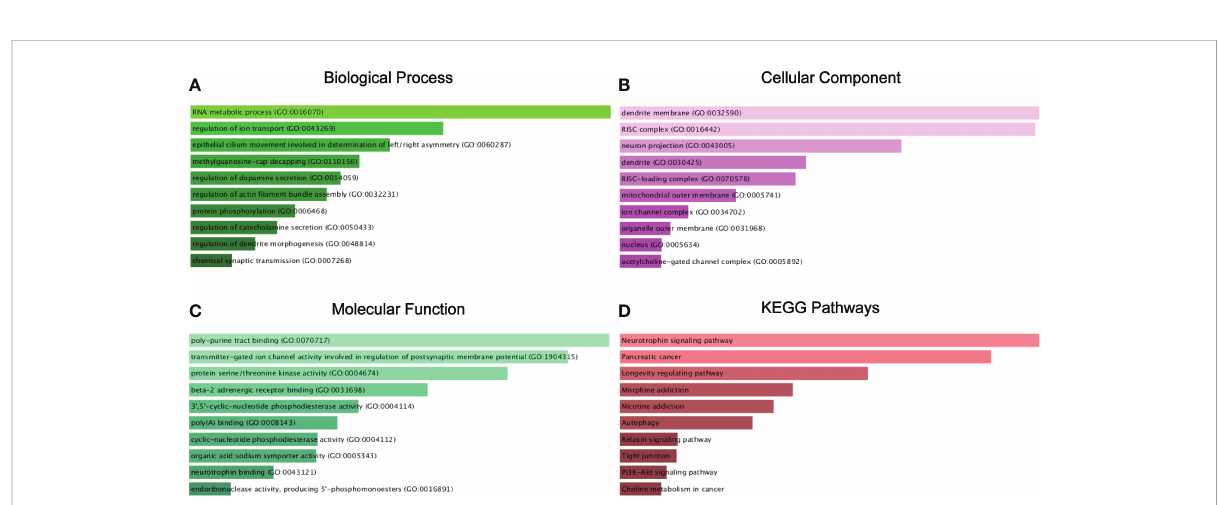
FIGURE 6 Target genes GO functional annotation and KEGG pathway enrichment analysis. Biological process (BP) analysis (A) , cellular component (CC) analysis (B) , molecular function (MF) analysis (C) , and KEGG pathway enrichment analysis (D)